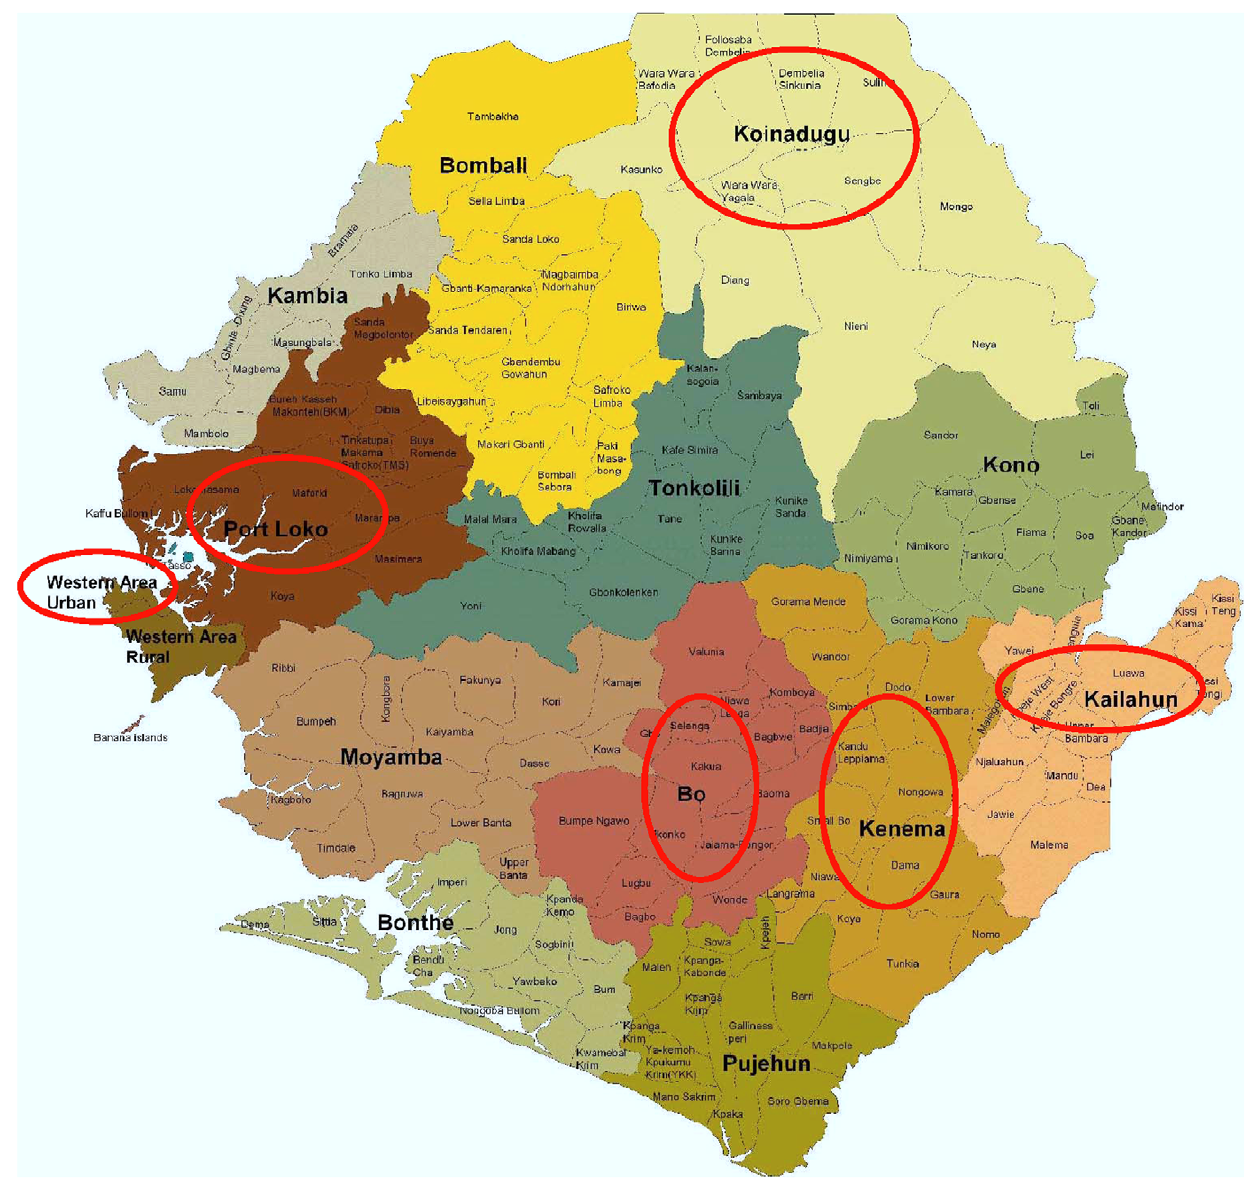
Figure 1. Anti-malarial market survey districts in Sierra Leone.